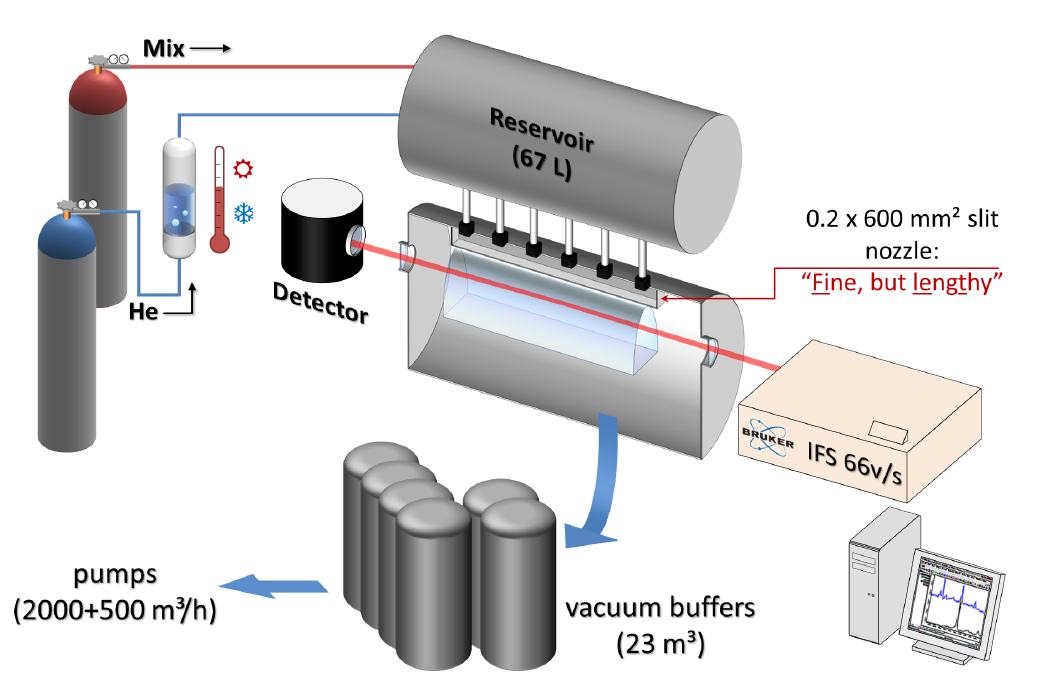
Figure 1. The filet jet spectroscopy setup. Taken from Ref. [84], licensed under CC BY-NC-ND